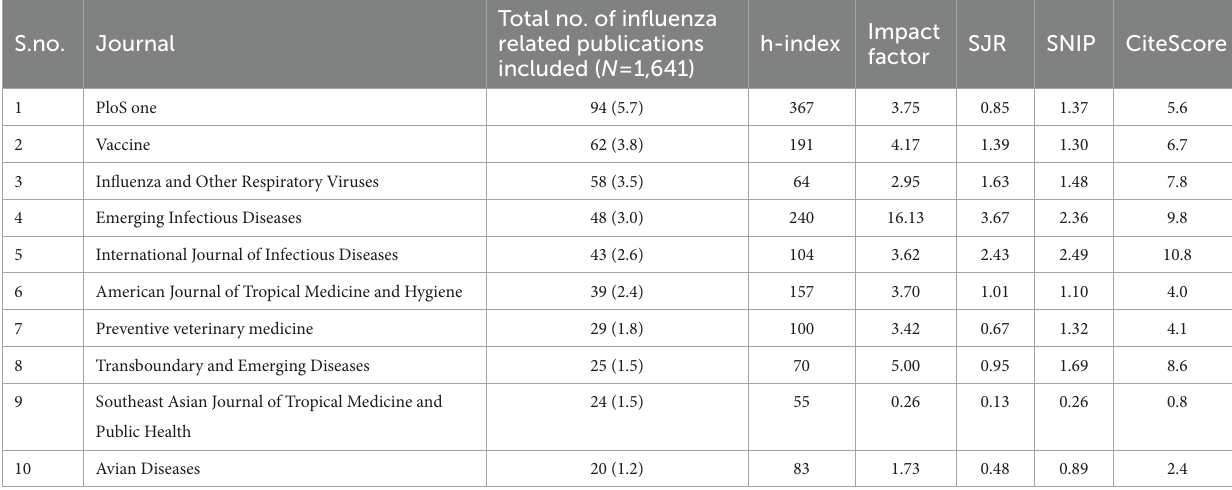
TABLE 4 List of top 10 Journals where Influenza-related research from South East Asia Region was published between 2000 and 2021.